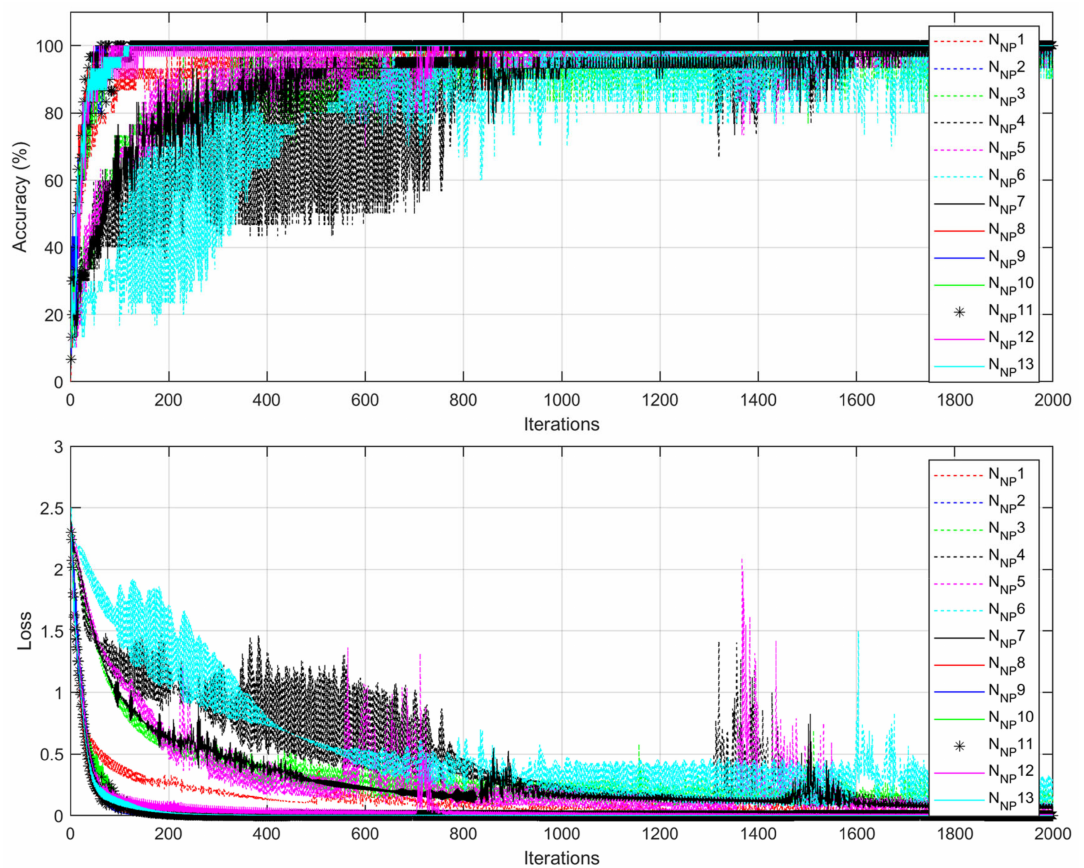
Figure A5. Training process and detection